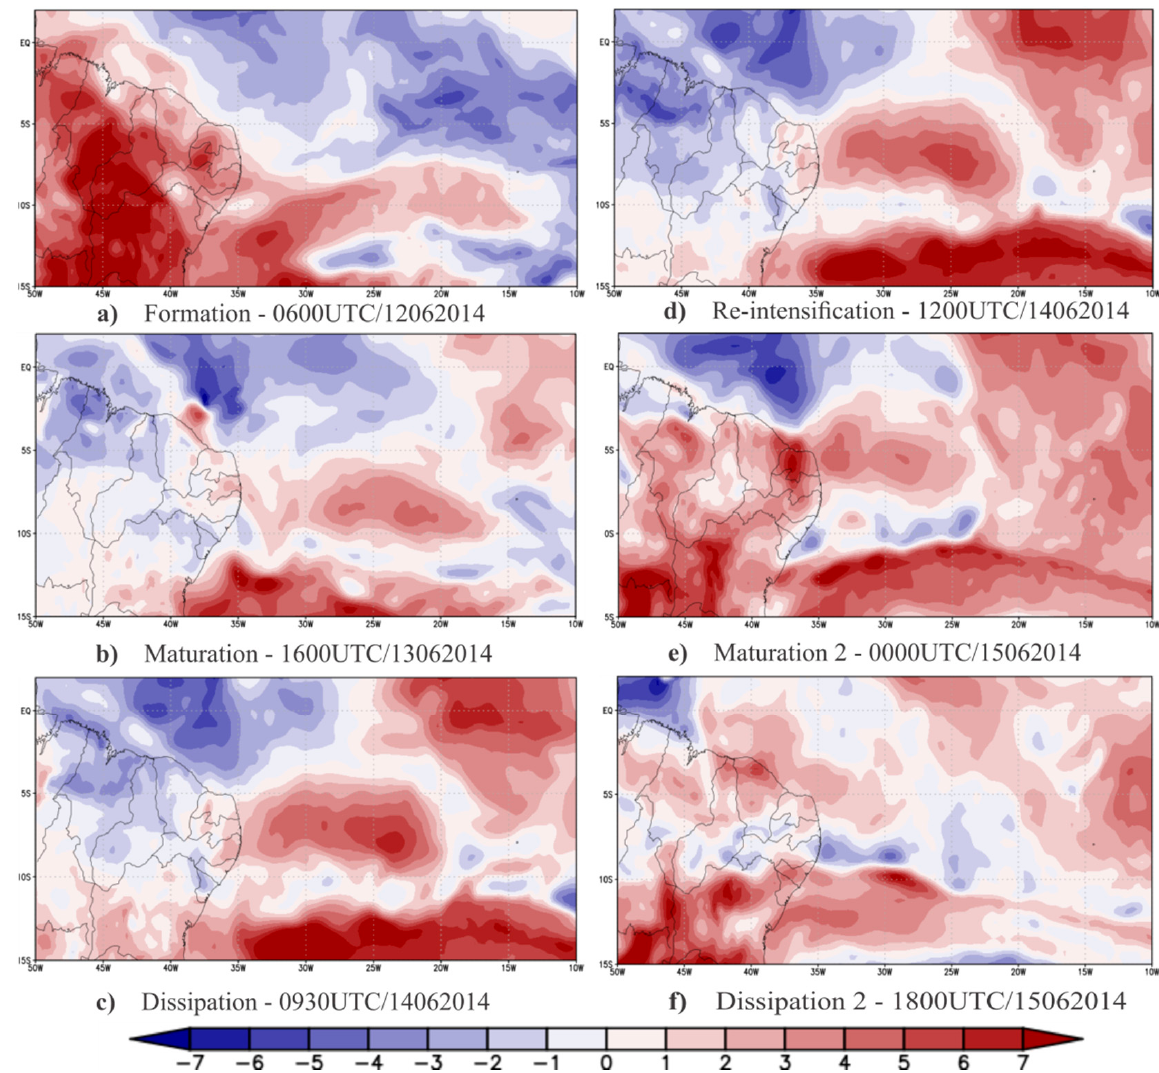
Figure 4. Anomalies of the wind speed in m/s for the phases ( a ) formation, ( b ) maturation, ( c ) dissipation, ( d ) re-intensification, ( e ) 2nd maturation, ( f ) 2nd dissipation of the Eastern Wave Disturbance.